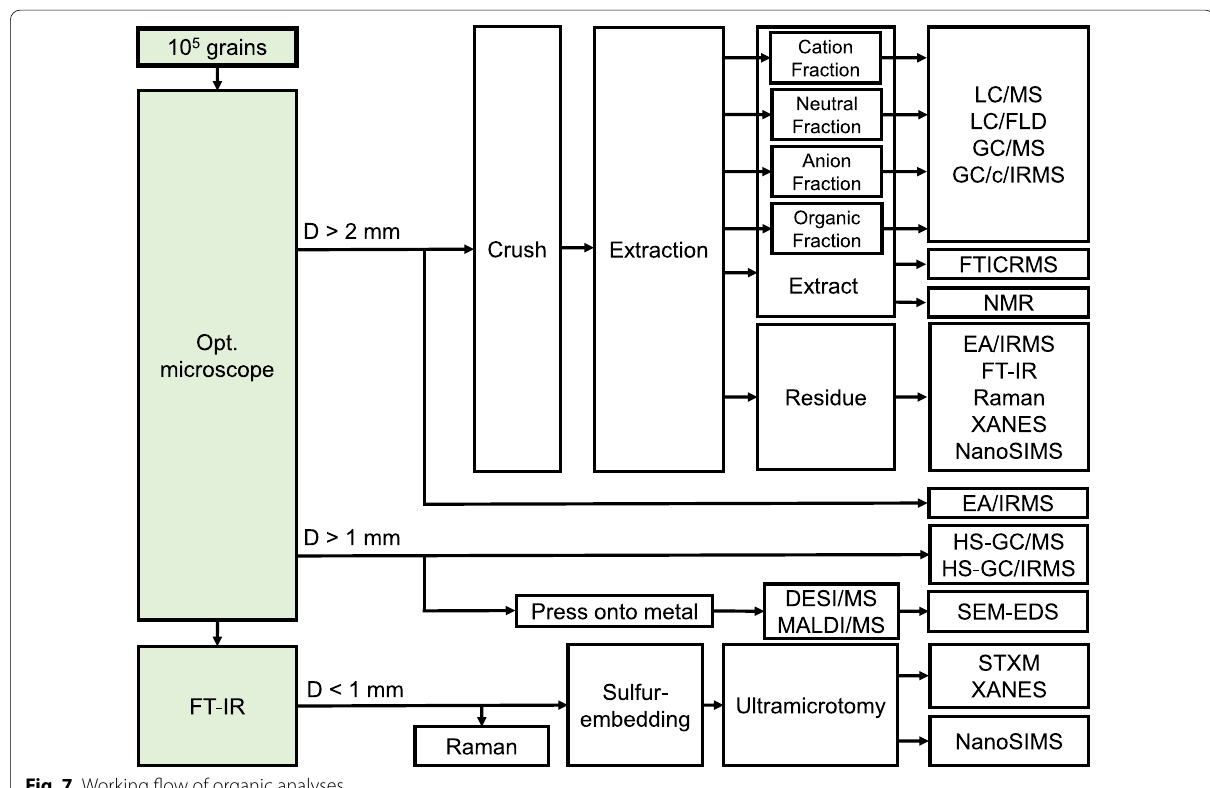
Fig. 7 Working flow of organic